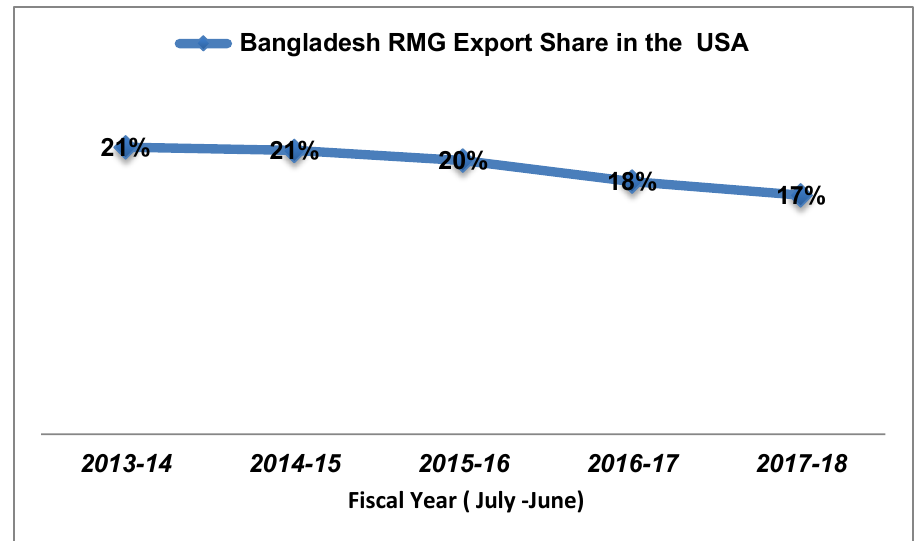
Figure 2: Bangladesh RMG Export Share in the USA Market (out of its total global RMG export share) Source: Calculated based on EPB Database,